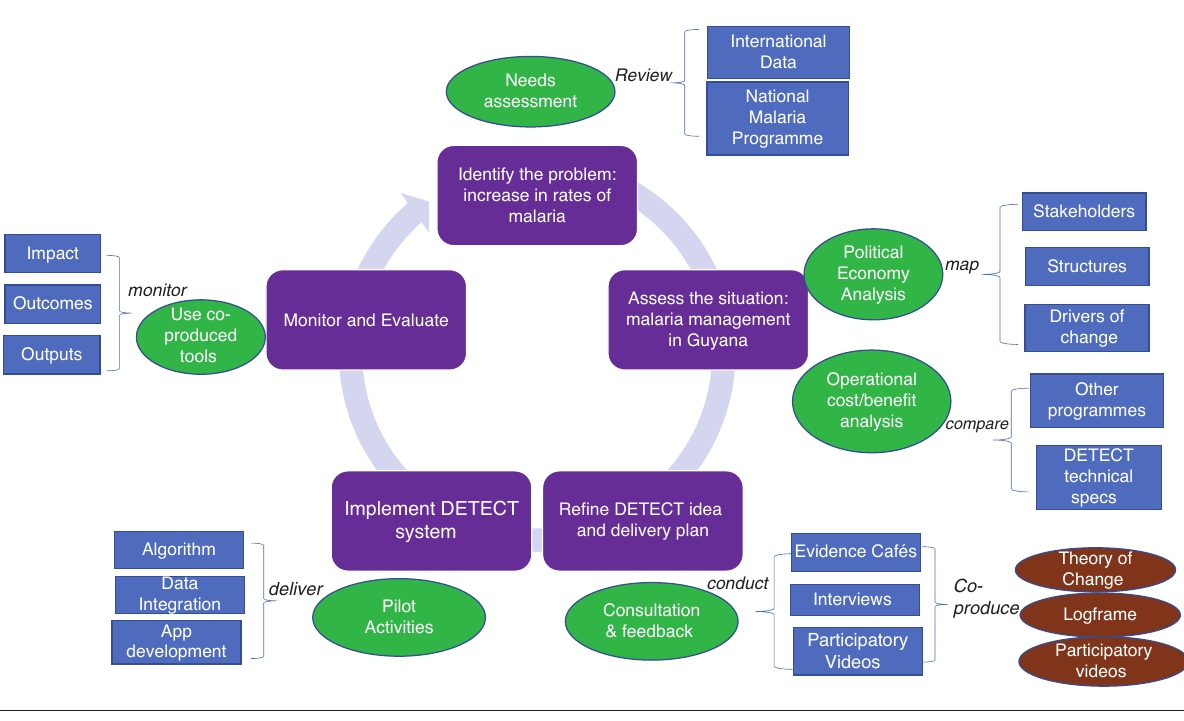
Figure 2. Overview of DETECT’s use of soft system methodology (Source: